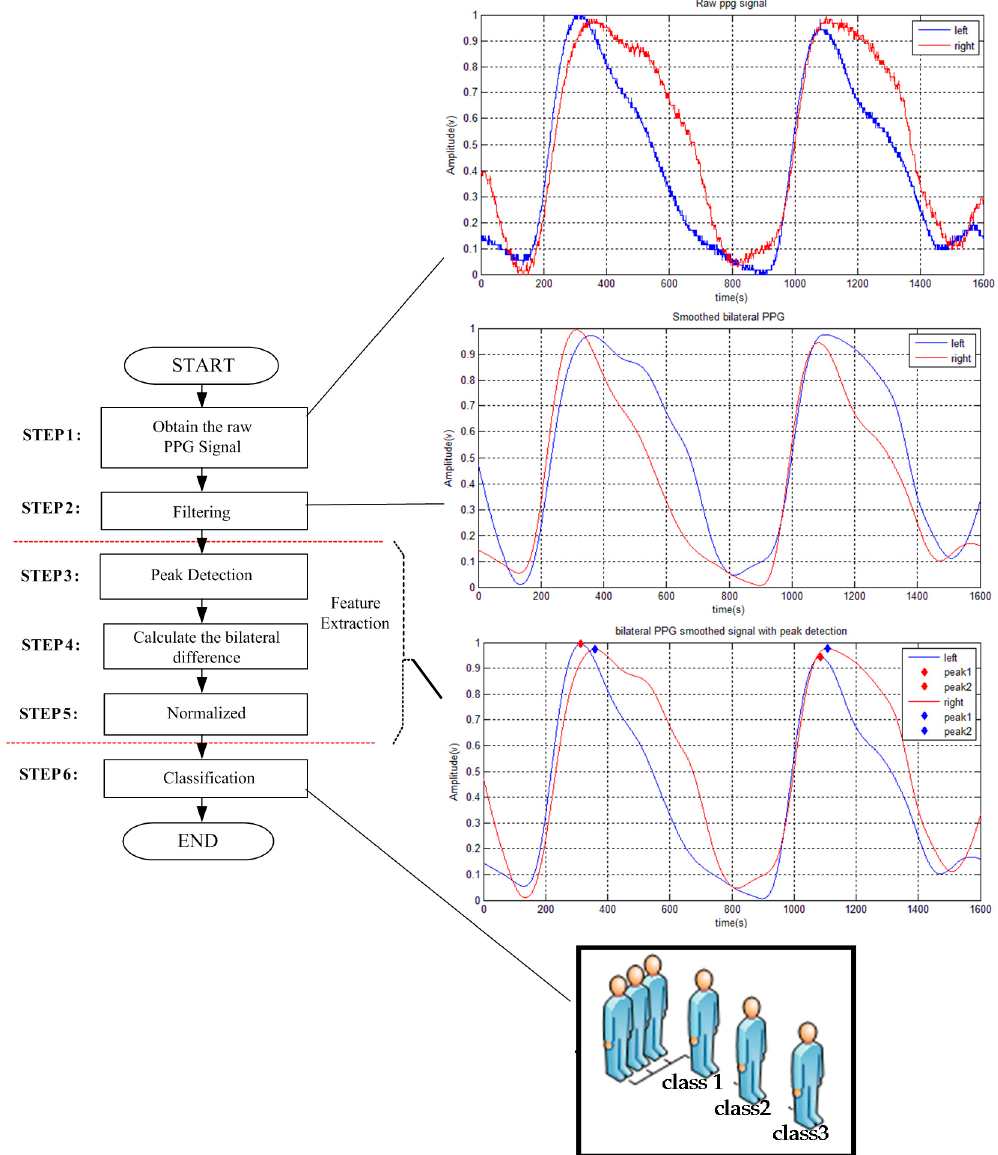
Figure 2. The method of the proposed system.